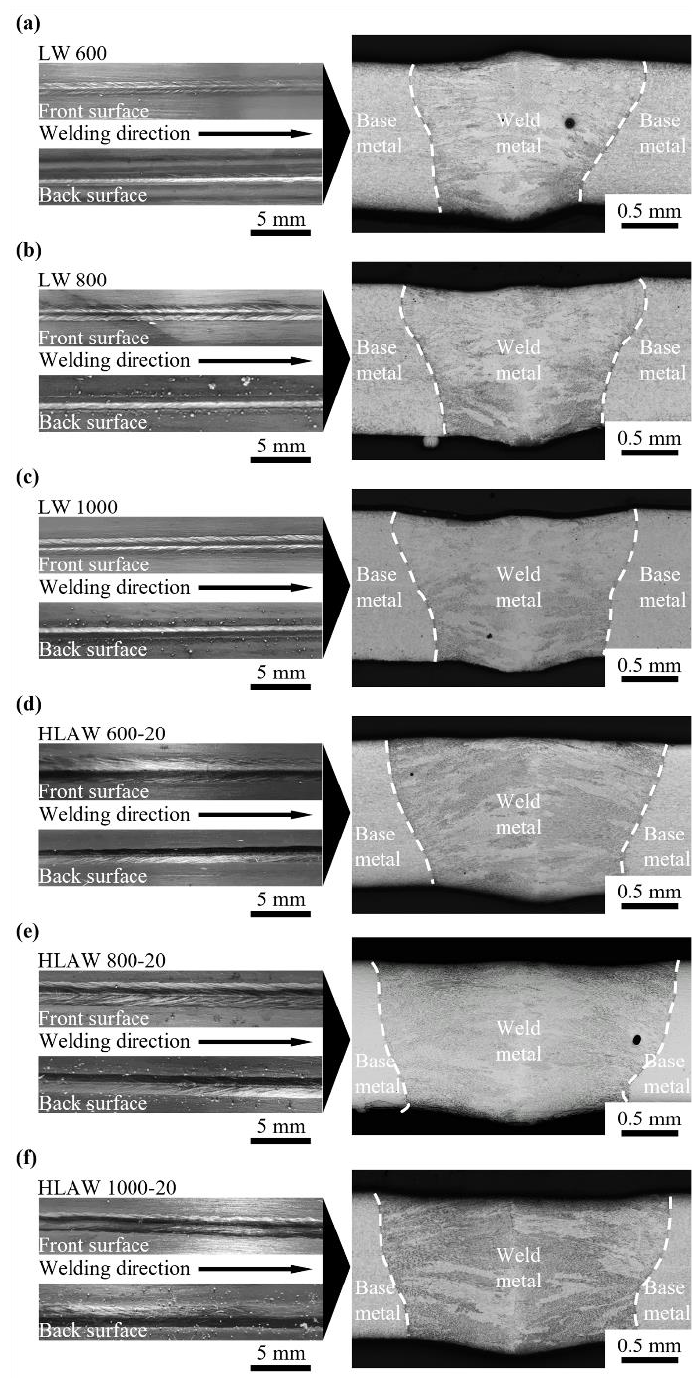
Figure 7. Surface forming and cross section morphology weld seams with different welding modes: ( a – c ) LW 600, LW 800, and LW 1000, respectively; ( d – f ) HLAW 600-20, HLAW 800-20, and HLAW 1000-20, respectively.